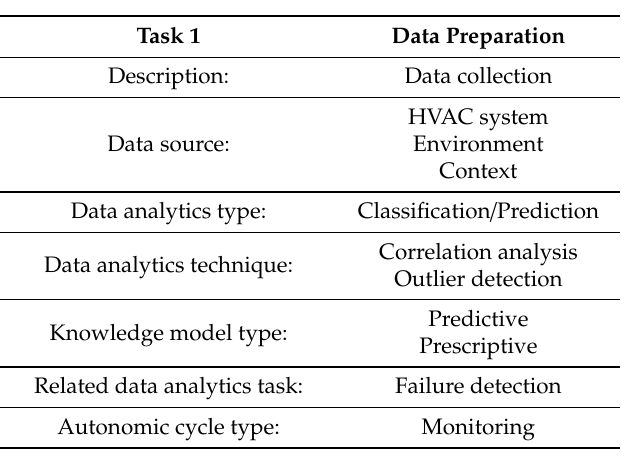
Table 2. Description of Task 1 of data